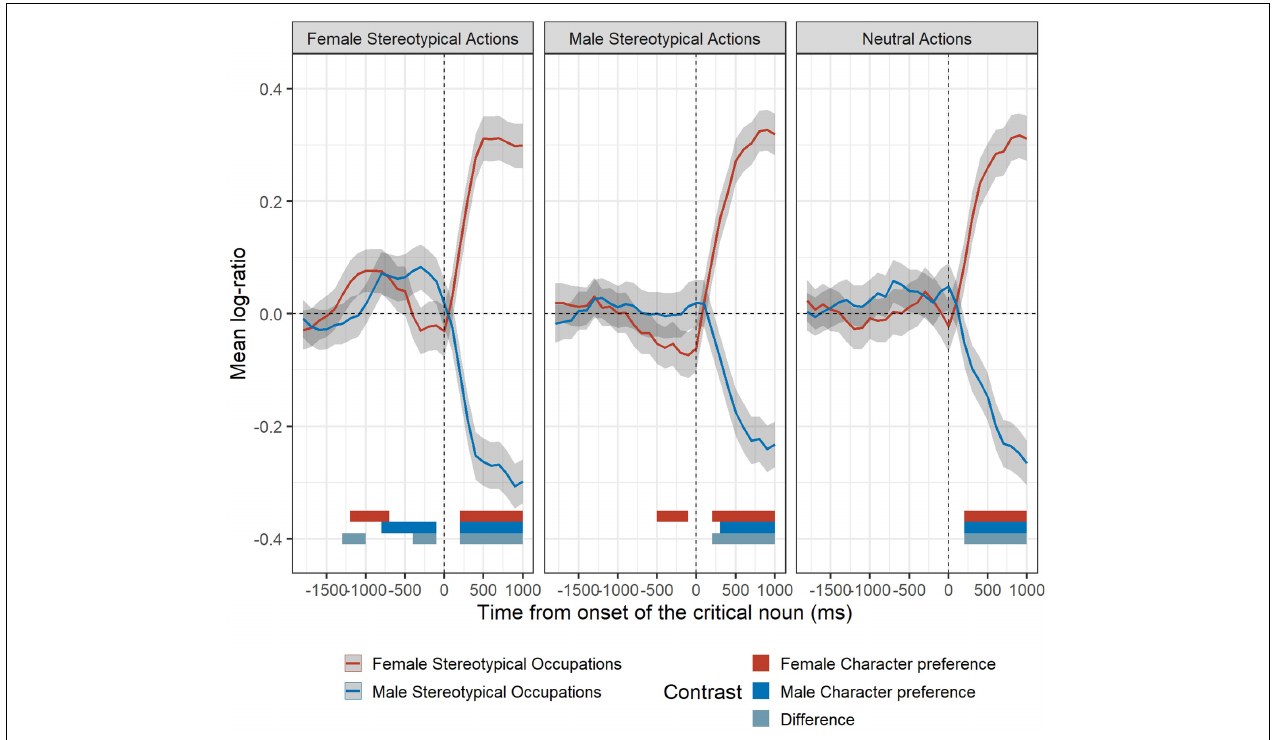
FIGURE 3 | Mean log-ratio between the female and male agents (positive and negative values reflect preference for the female and male character, respectively), as a function of the action experimental condition (neutral actions, female-stereotypical actions, male-stereotypical actions), and aggregated in time steps of 100 ms. Plots are time-locked to the onset of the critical noun. Occupation experimental conditions (female-stereotypical occupations, male-stereotypical occupations) are represented by different line colors. Shaded areas represent within-subject adjusted 95% confidence levels, calculated at the participant level. Bottom horizontal bars visually represent the extent (in milliseconds) of identified significant cluster for each contrast and action experimental